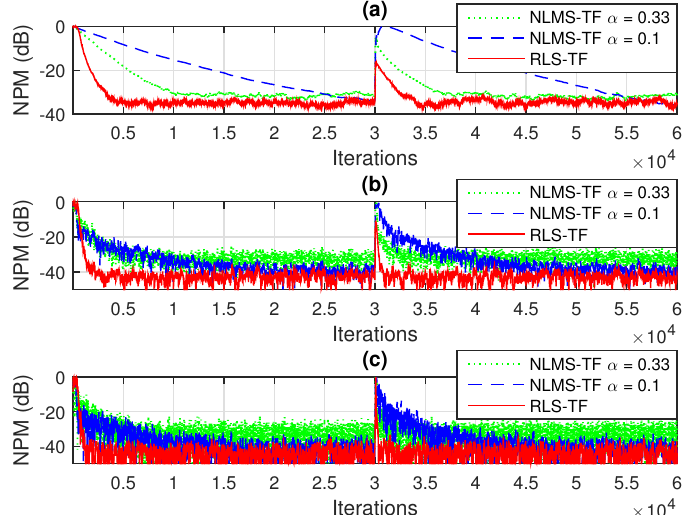
Figure 5. Normalized projection misalignment (NPM) evaluated based on (55)–(57), in dB, for the identification of the individual impulse responses from Figure 2a–c, using the NLMS-TF algorithm [17] (with different normalized step-sizes α 1 = α 2 = α 3 = α ) and the RLS-TF algorithm (with the forgetting factors λ i = 1 − 1/ ( KL i ) , i = 1,2,3, where K = 20): ( a ) NPM